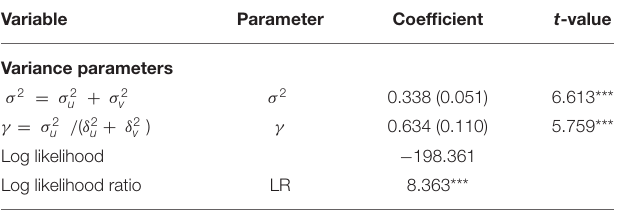
TABLE 3 | Variance parameters of stochastic translog profit function. Variable